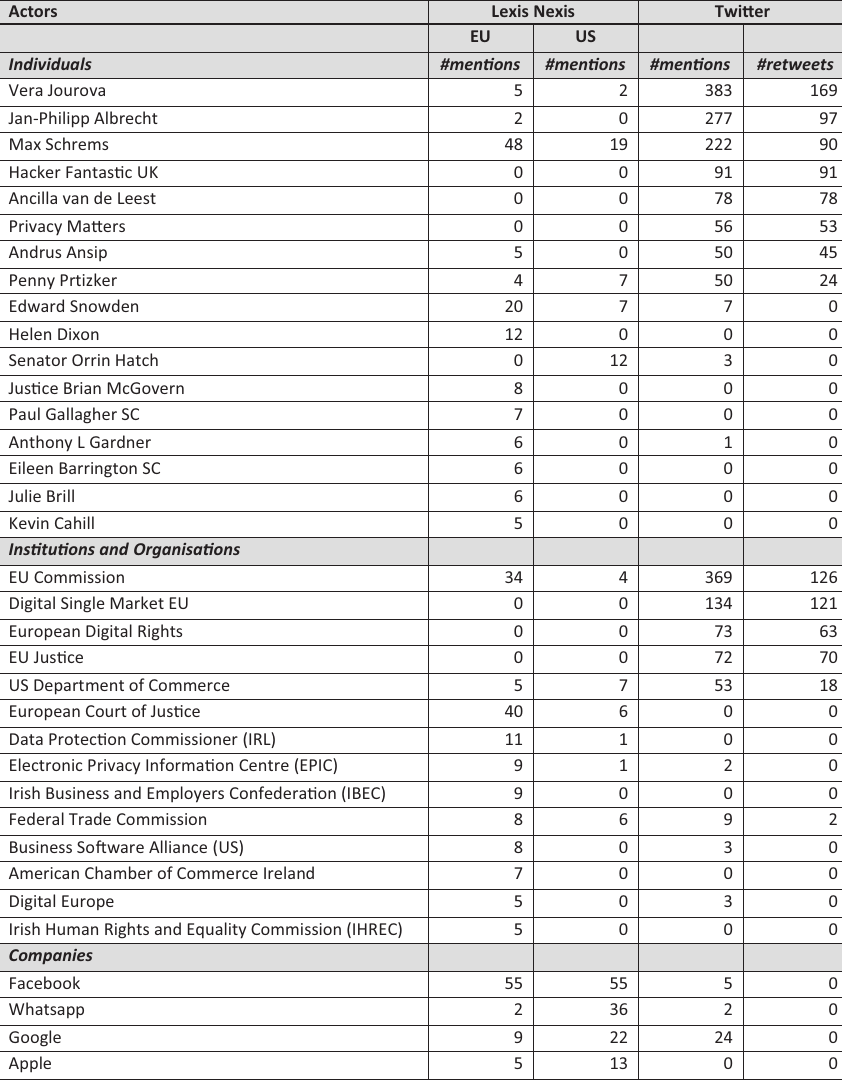
Figure 1: Modified table of key